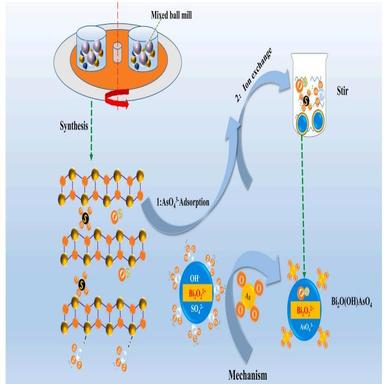
The mechanism of removing As (V) pollutant.